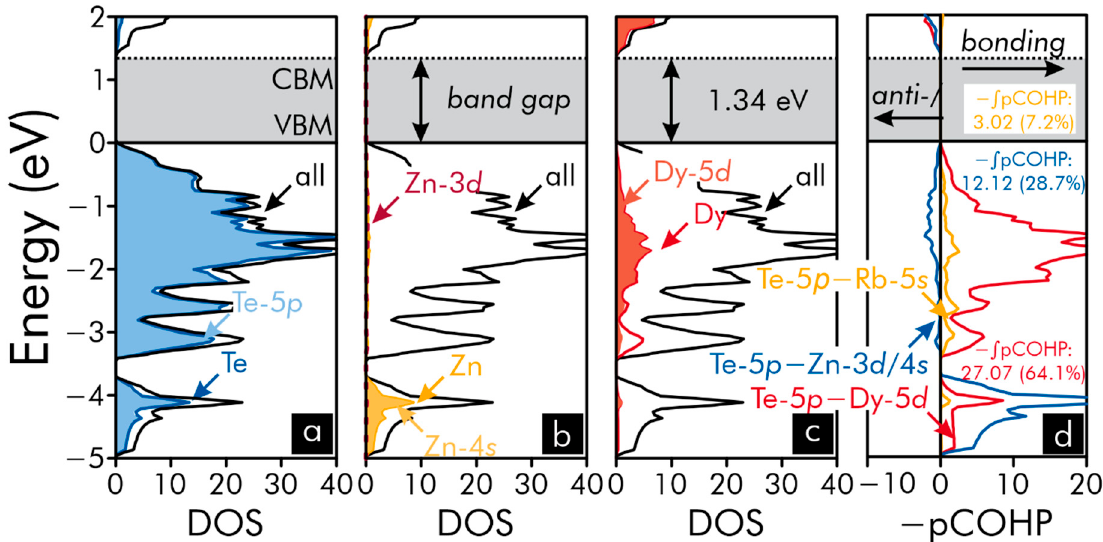
Figure 3. ( a – c ) Densities-of-states (DOS) curves of RbDyZnTe 3 : the valence band maximum (VBM) and conducting band minimum (CBM) are represented by the lower and upper black horizontal lines, respectively, while the atom- and orbital-projected DOS are included; ( d ) projected crystal orbital Hamilton populations (pCOHP) of RbDyZnTe 3 : the cumulative integrated values as well as percentages of every inspected interaction to the net bonding capabilities (see main text) are included.